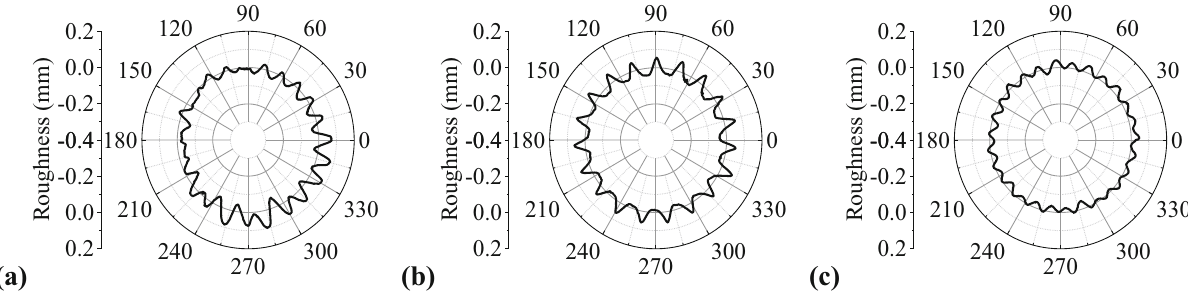
Fig. 5 Typical measurement results of polygonal wear of high-speed train wheels in China described in polar coordinates: a CHR2 EMU, b CRH3 EMU, and c CRH5 EMU with nominal wheel diameters of 860 mm, 920 mm, and 890 mm, respectively